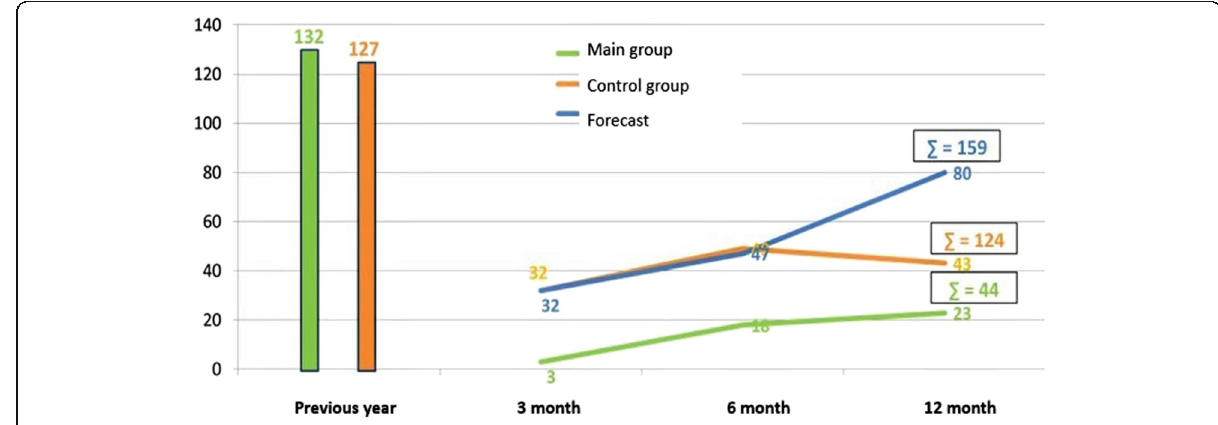
Fig. 4 The number of recurrences in